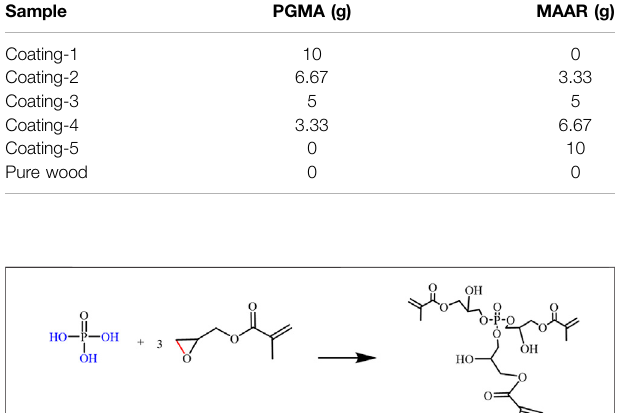
TABLE 1 | Formulation of different coatings. Sample